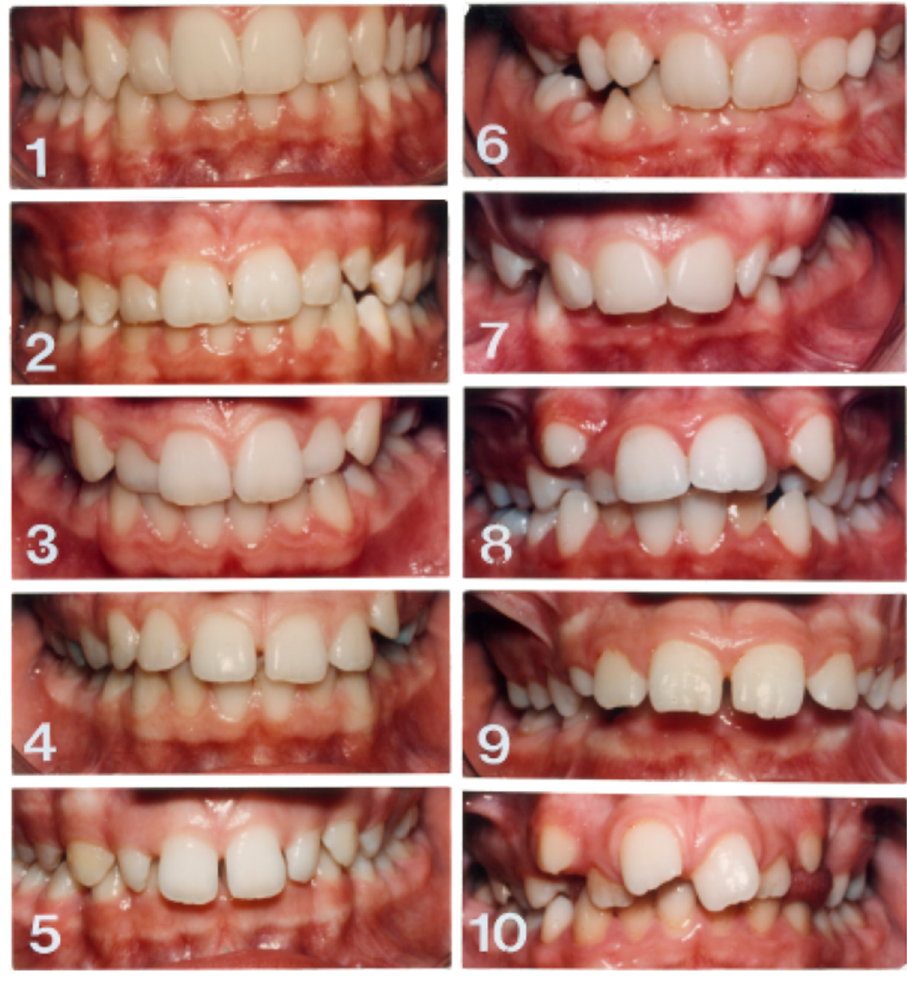
Figure 2. IOTN Aesthetic